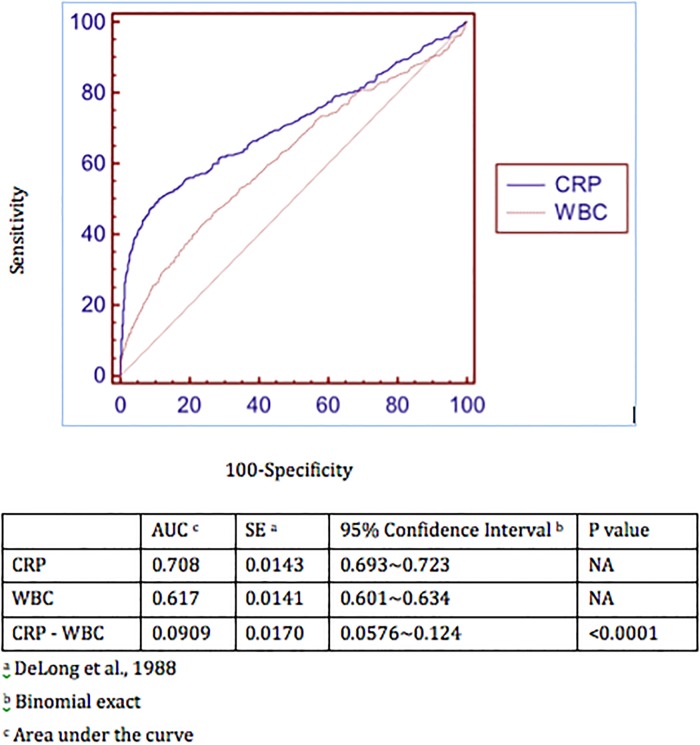
Comparison of ROC curves between CRP and WBC in blood of patients for the decision of antibiotics prescription.